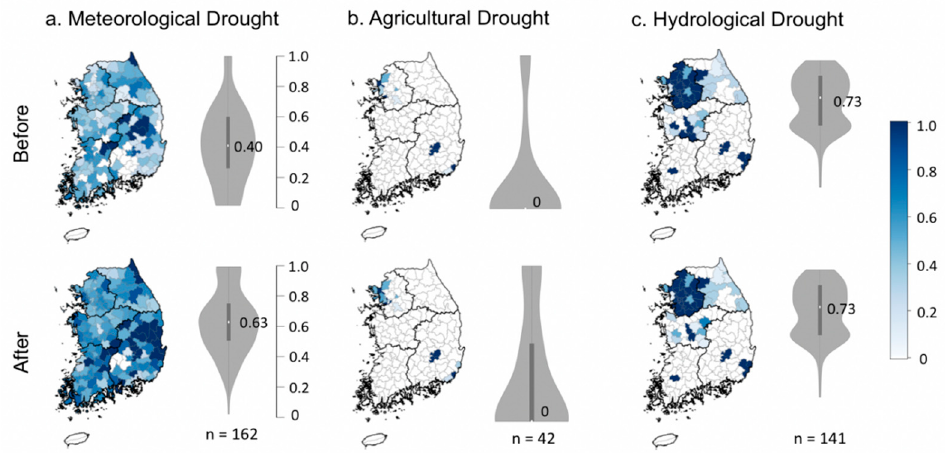
Figure 3. Specificity distribution of the ground data-based drought index (before and after weight correction).